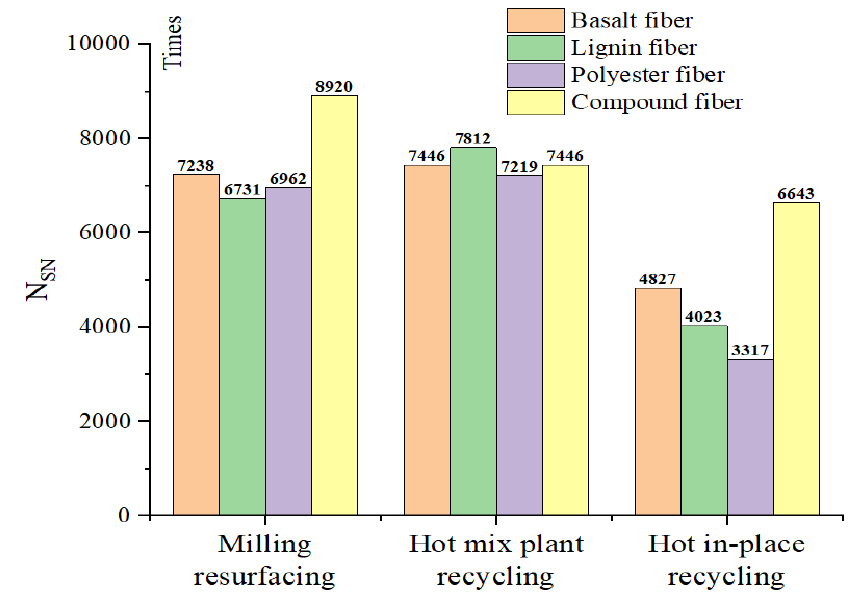
Figure 22. 𝑁 (cid:3020)(cid:3015) of each fiber asphalt mixture Figure 22. N SN of each fiber asphalt mixture. The intersection point (i.e., 𝑁 ) manifests itself earlier as the RAP content increases, Table 11. Fitting parameters of the negative curvature (cid:3020)(cid:3015)